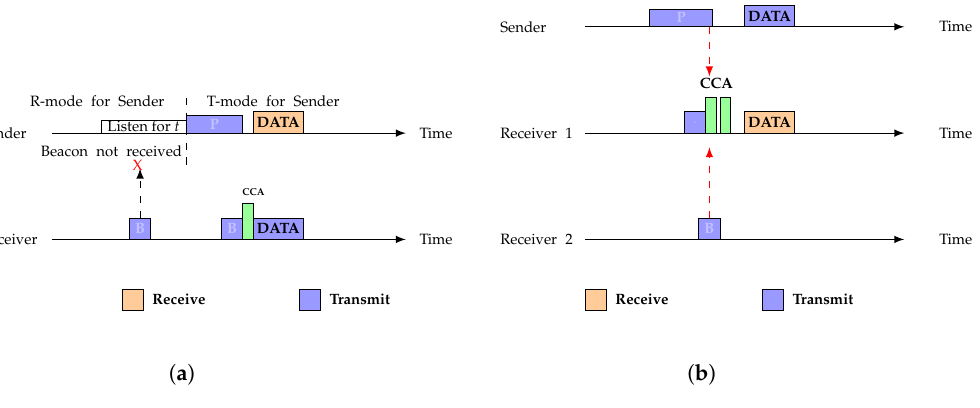
Figure 2. Working mechanism of ASYM-MAC protocol: ( a ) operation of the ASYM-MAC protocol; and ( b ) a collision